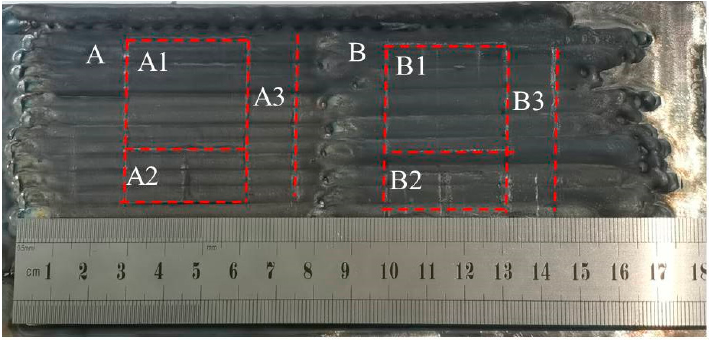
Figure 2. Specimen areas dedicated for wear (A1, B1), microstructure (A2, B2) and hardness (A3, B3) testing. coating A: one-layer, coating B: two-layer